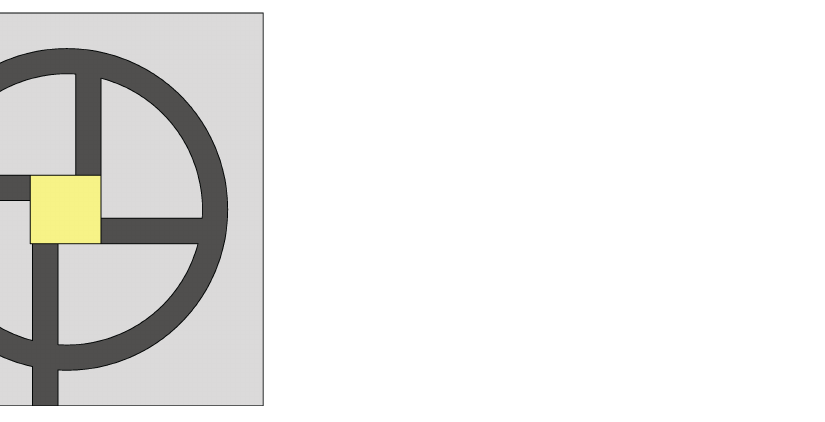
Figure 33. Schematic of the circular polarized DRA for biomedical applications (redrawn from [131]). Dark gray top metal face, light gray dielectric substrate, and medium yellow DRA.